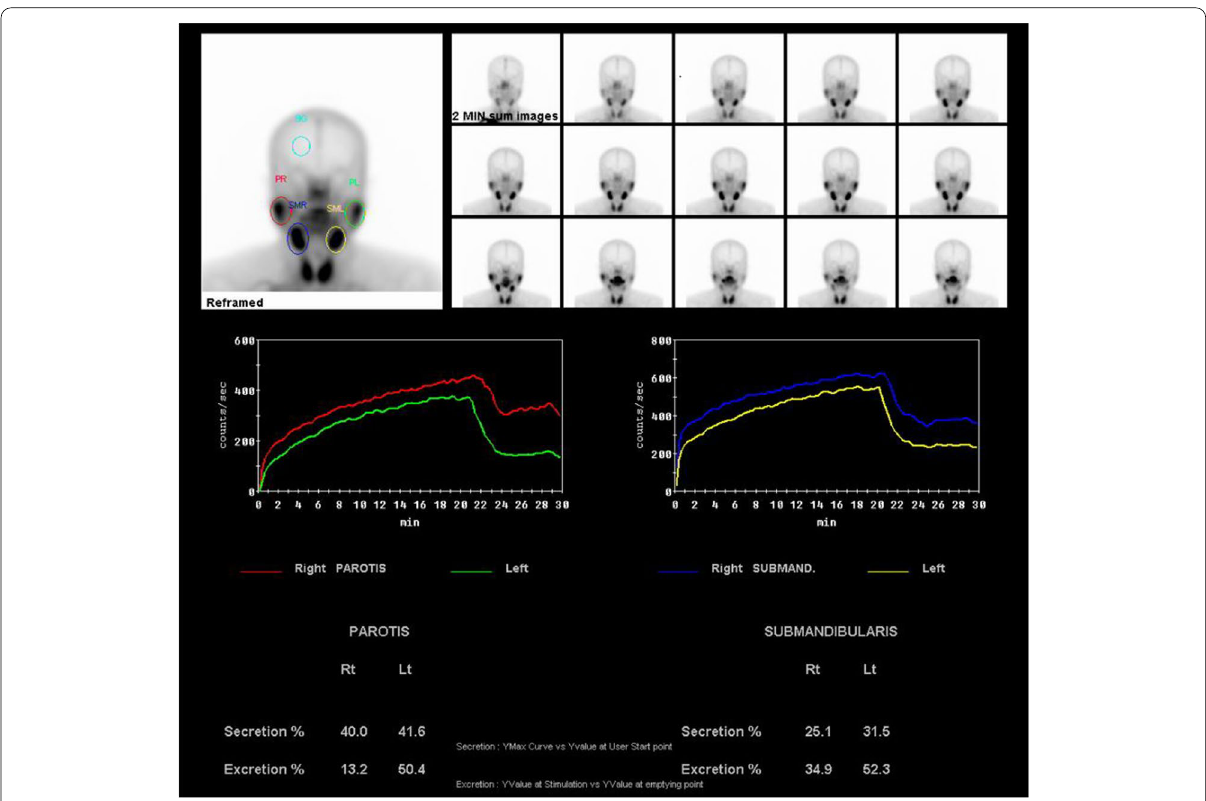
Fig. 2 Salivary scintigraphy image with decreased salivary flow